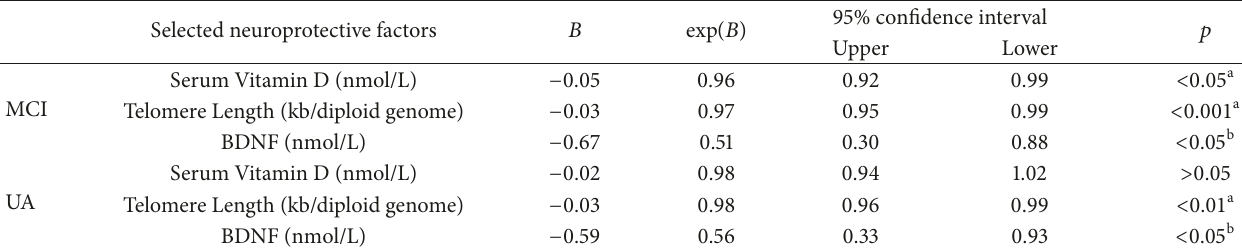
Table 3: Determination of significant neuroprotective factors associated with risk of cognitive